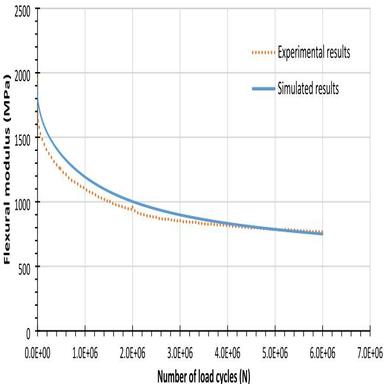
Comparison of simulated and experimental results: strain-controlled fatigue test .